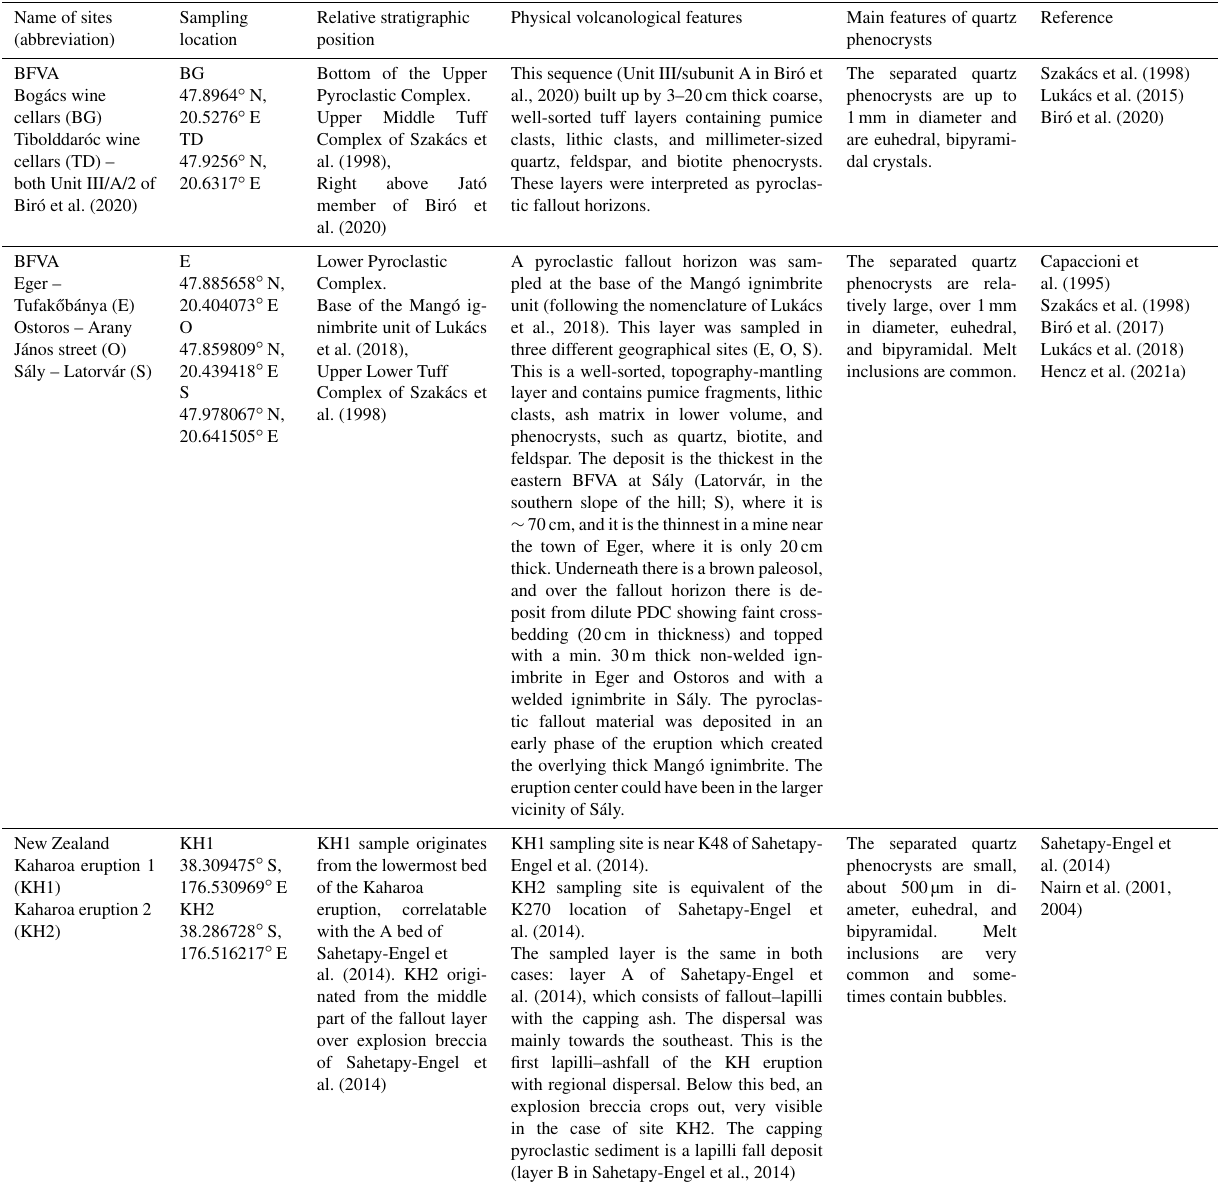
Table 1. Location of the sampled pyroclastic fallout deposits and their relative regional stratigraphic positions with basic volcanological descriptions (based on recent